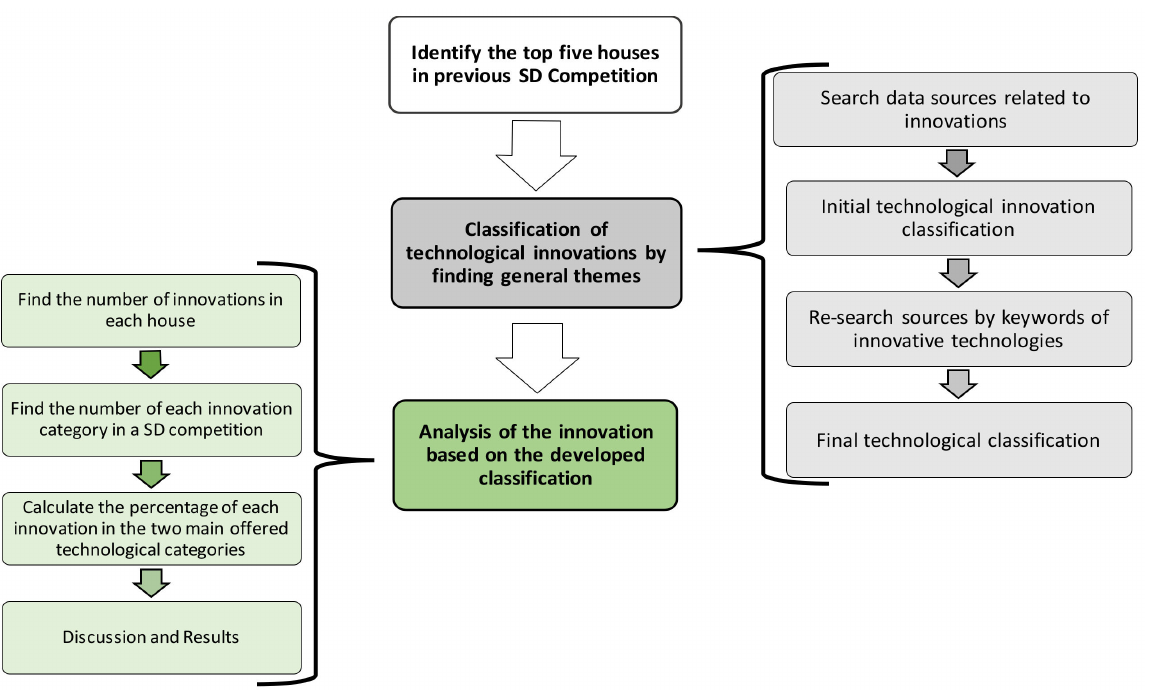
Figure 1. Data analysis methodology used in this